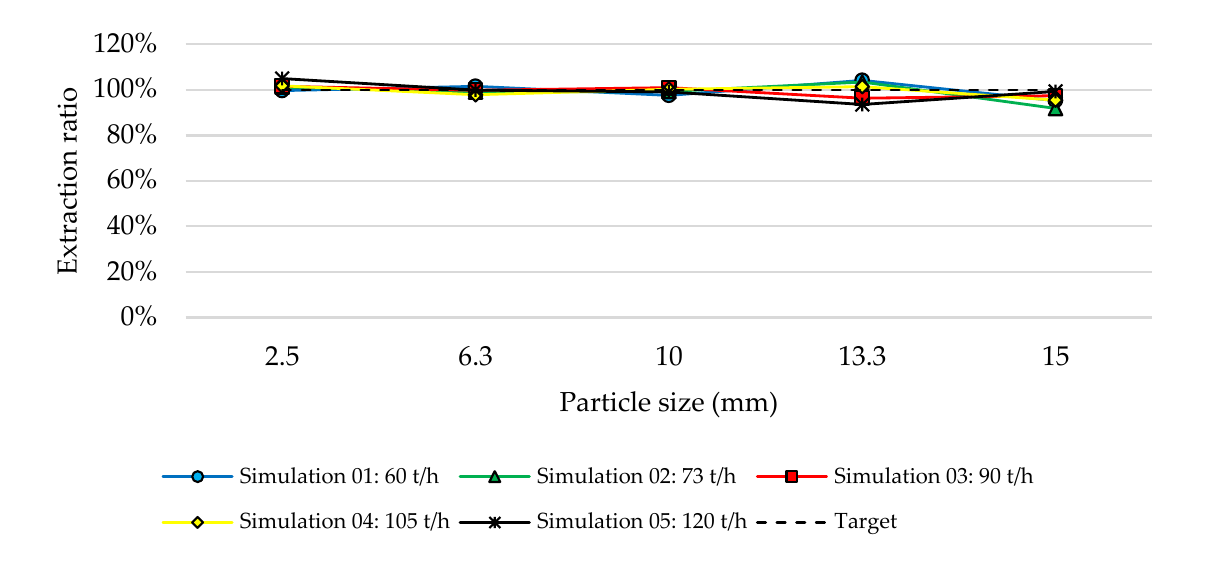
Figure 13. Extraction in cross-stream cutter as function of cutter velocity.